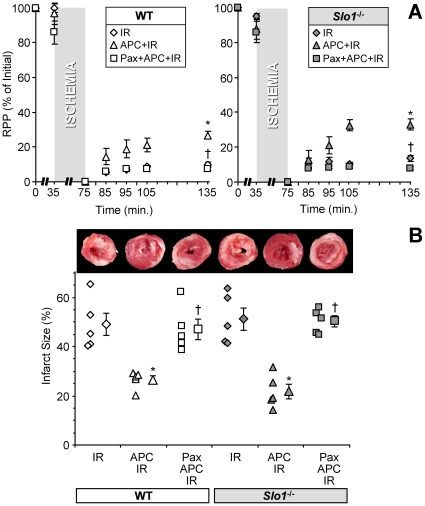
APC in mouse hearts is independent of Slo1.
Perfused hearts were subjected to IR injury, APC+IR, or paxilline (Pax)+APC+IR, as outlined in the methods section of Supporting Information S1. (A) Left-ventricular function (heart rate x pressure product, RPP) was monitored throughout, and is expressed as % of initial value. Data for WT (white symbols) and Slo1-/- (gray symbols) FVB littermates are shown on separate axes for clarity. (B) Upon completion of IR protocols, hearts were sliced, fixed and stained with TTC, to delineate live (red) and infarcted (white) tissue. Upper panel shows typical slices used for quantitation of infarct area. Lower panel shows infarct expressed as a percent of the area at risk (100% in this global ischemia model). Data are means ± SEM, N = 5 (N = independent hearts) *p<0.05 vs. IR, †p<0.05 vs. APC+IR.